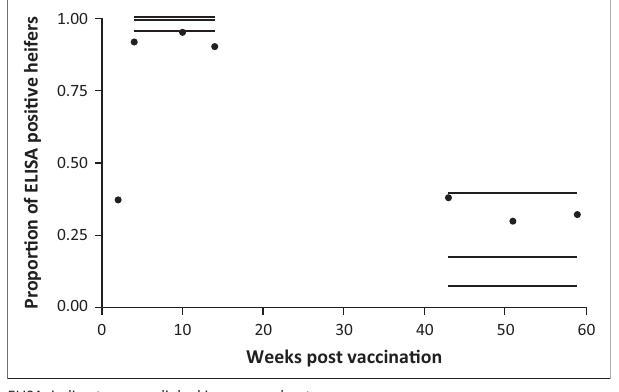
FIGURE 4: Observed proportion of indirect enzyme-linked immunosorbent assay–positive case results over time using categorical logistic regression and with 95% confidence intervals. TABLE 1: Serological and skin test results of seven cases 4.5 years after vaccination. Animal